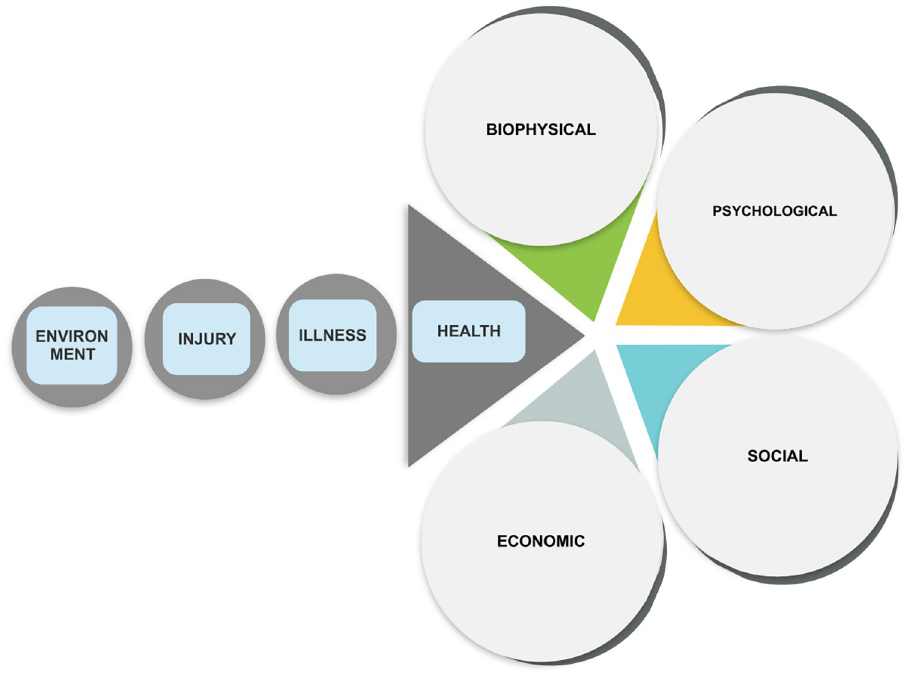
Fig 3. Impact on health model—based on the four domains synthesised in this